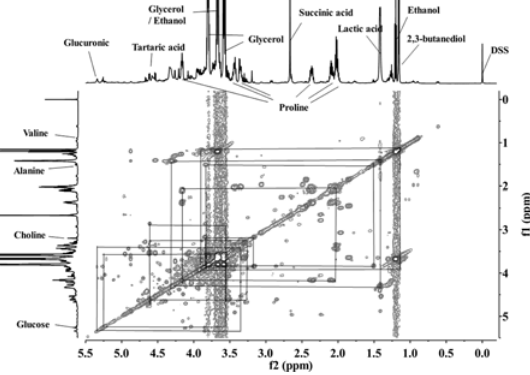
Fig 1. The 1 H- 1 H COSY NMR spectrum of lyophilized Cabernet Sauvignon dry red wine.